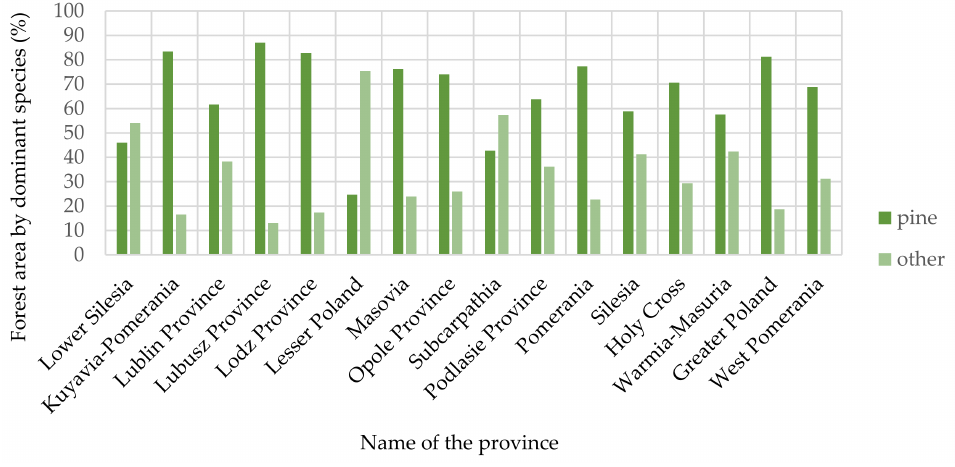
Figure 1. The area of forests on forest land by prevailing species in the voivodship system